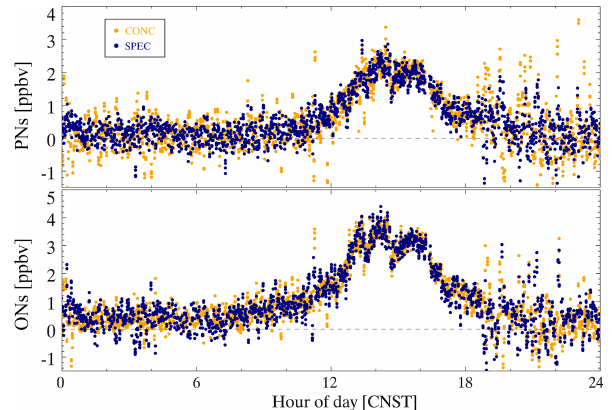
Figure 6. An example of the calculation results of the fixed I 0 (“CONC”) and dynamic I 0 (“SPEC”) methods performed in the field measurements. Orange points represent the results of the CONC method, and dark blue points represent the calculation re- sults of the SPEC